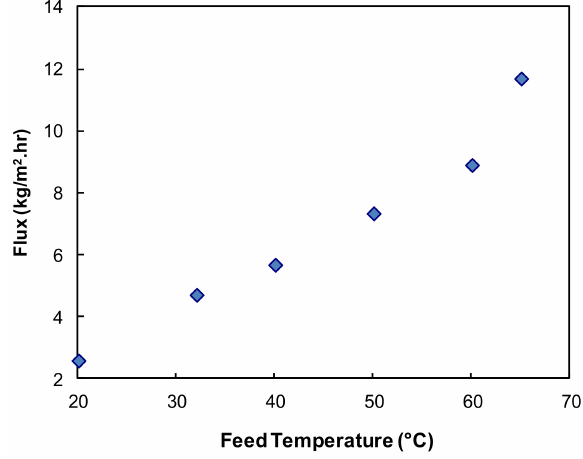
Figure 3. Effect of feed temperature on water flux (membrane thickness 20 µ m, feed velocity 0.05 m/s, vacuum 6 Torr).